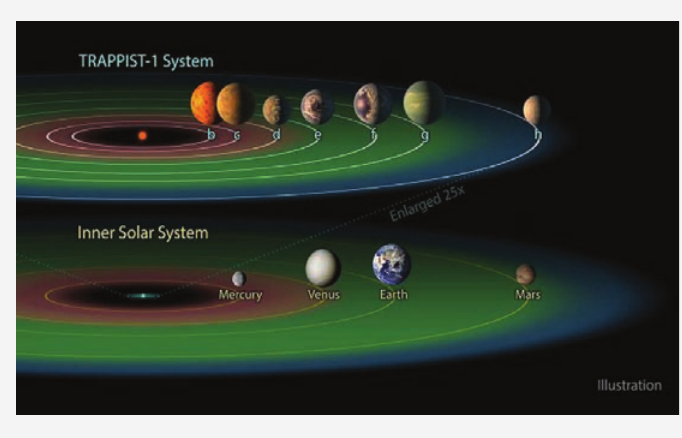
Figure 2. The TRAPPIST-1 planetary system is one of the many recently discovered planetary systems orbiting other stars in our galaxy. Three of the seven planets of this system lie within the habitable zone, where liquid water might exist on the planetary surface. It is likely that such planets could support life, at least in local environments. Detecting signs of life on exoplanets is one of the great questions energizing current astronomical